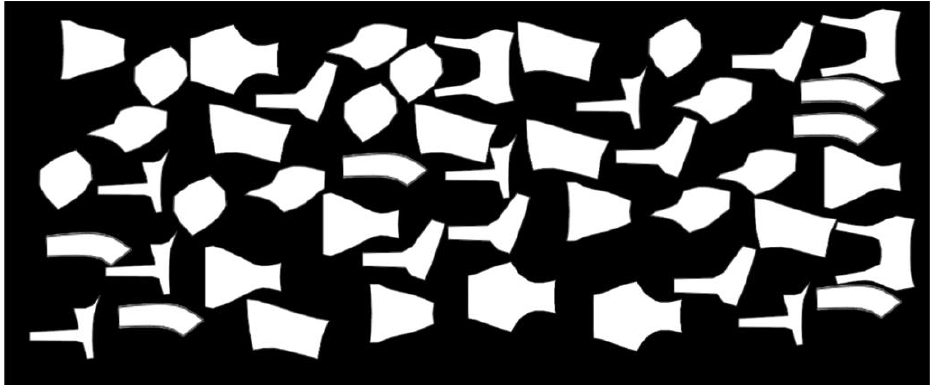
Figure 11. Solution found by the ILS algorithm using 48 pieces for the Swim instance.